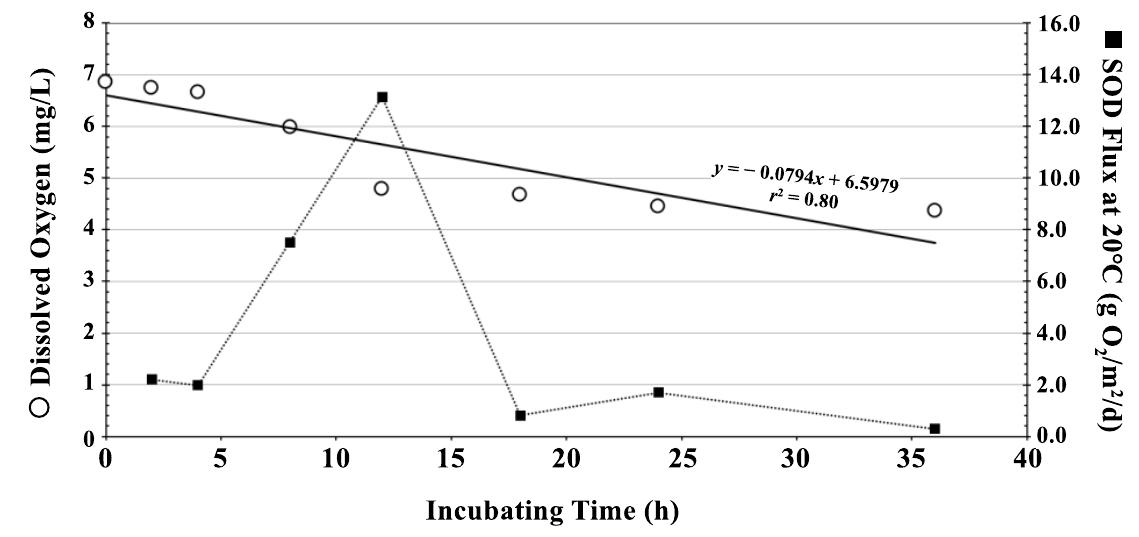
Figure 7. Results of the sediment oxygen demand (SOD) chamber experiment for dissolved oxygen ( ○ , solid line) and SOD 20 Flux ( ■ , dotted line), which depended on incubating times in the reducing environment due to anoxic water at GA4, Gamak bay, Korea.